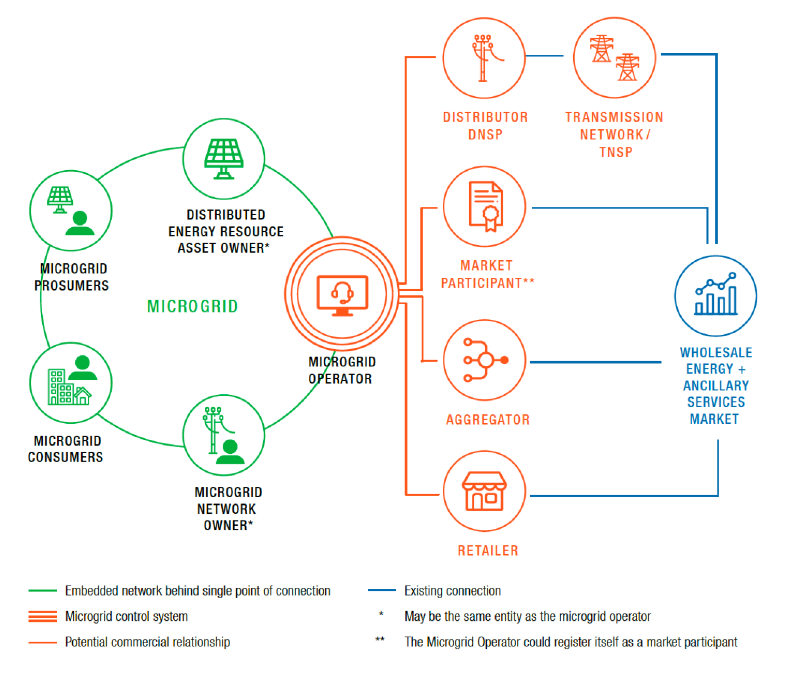
Figure 1. Core elements of a